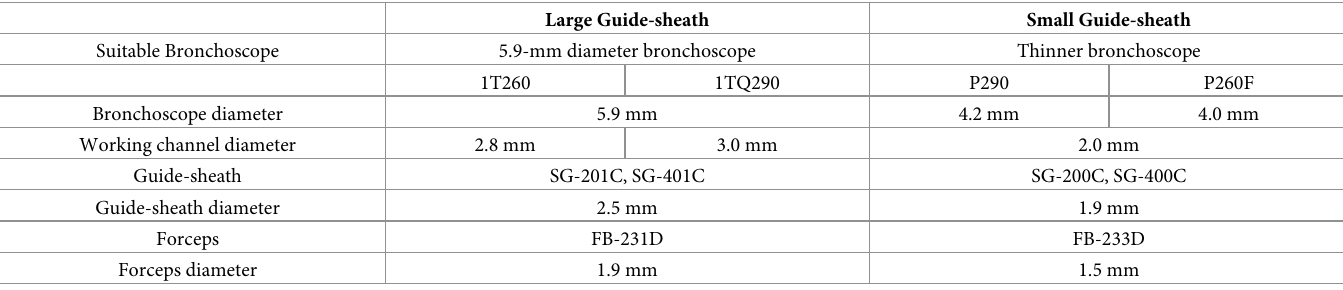
Table 1. Two different sizes of guide-sheaths and the suitable